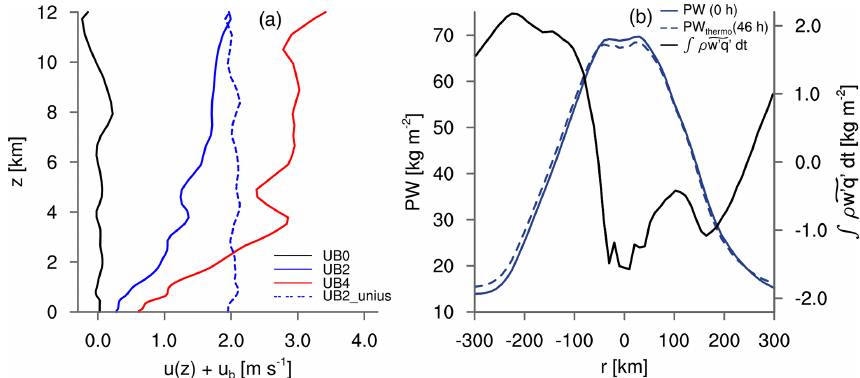
Figure 5. (a) Vertical profile of the domain-mean x -component wind as sum of the modeled wind u(z) in the x direction and u b for the quasi-stationary stage. Note that the horizontal wind considers the Galilean transformation by including u b . (b) Radial distributions of PW at 0h, the estimated PW at 46h due to the thermodynamic process alone, and the accumulated surface moisture flux anomaly from 0 to 46h. The quantities are azimuthally averaged.